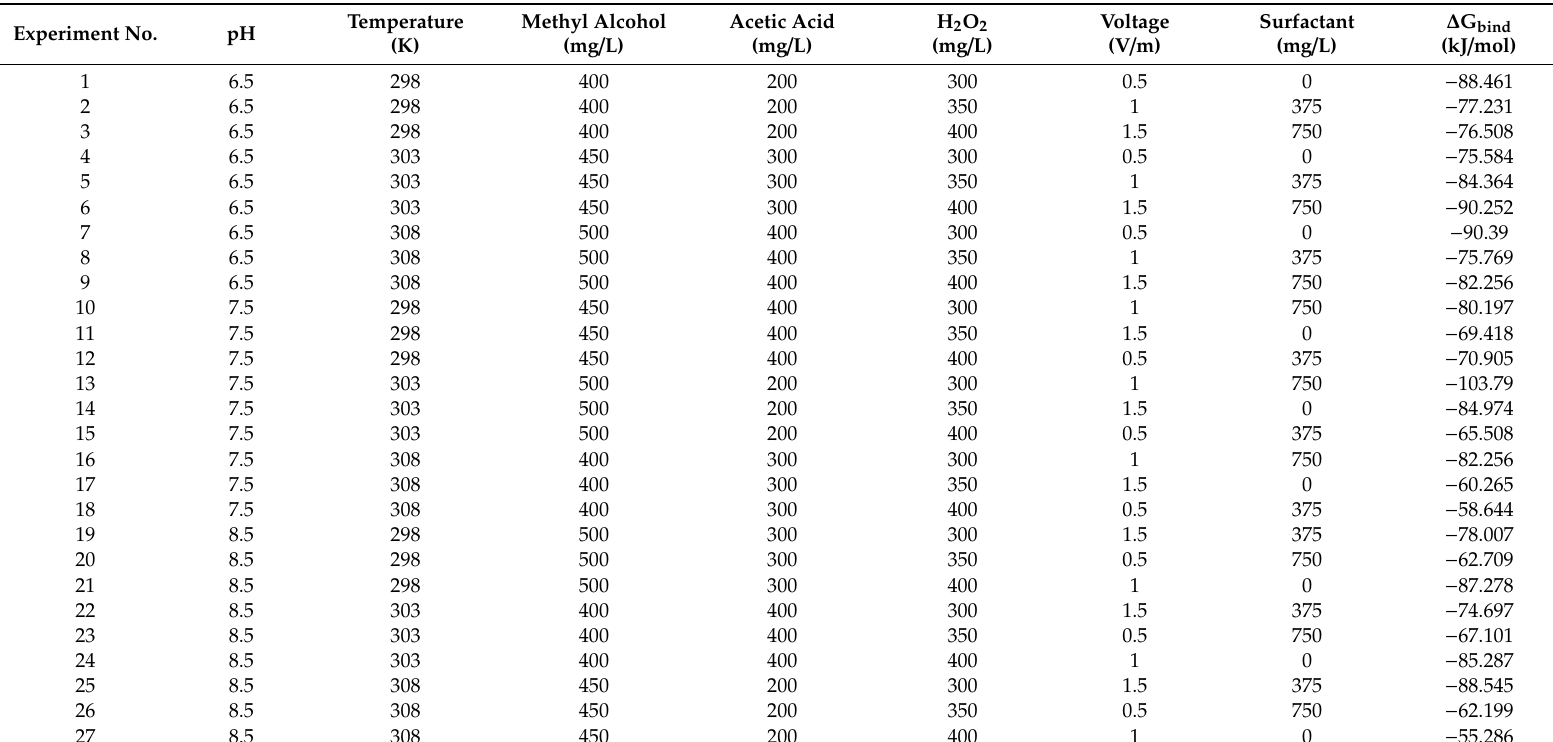
Table 7. E ff ect of the combination of external conditions on the biodegradation system of degrading enzyme and TCPP–OH. Experiment